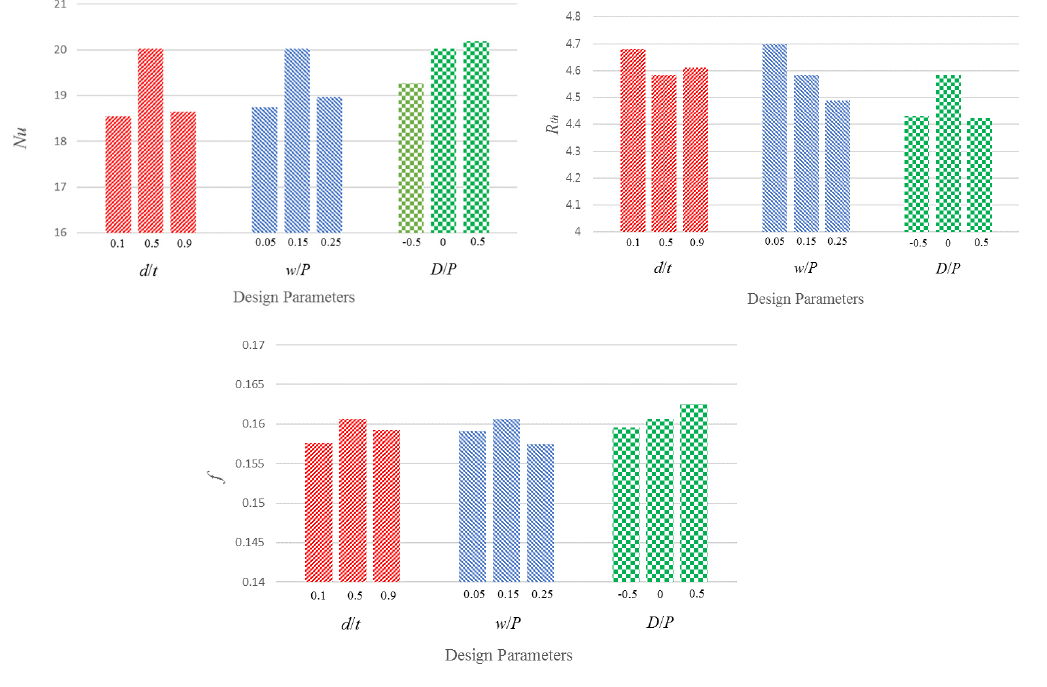
Figure 13. Results of the parametric